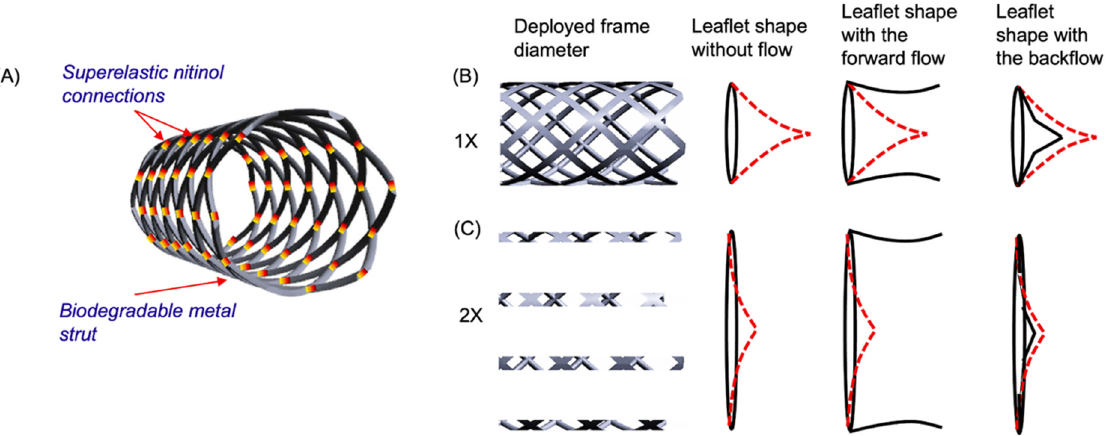
Figure 1. Schematic illustration of a growing pediatric percutaneous heart valve frame concept: ( A ) en face view of the frame that contains both superelastic nitinol and biodegradable metal, ( B ) original dimension of the device, showing the angle of leaflet, and ( C ) 200% increased dimension of the device with the leaflet angle change assuming the growth of the